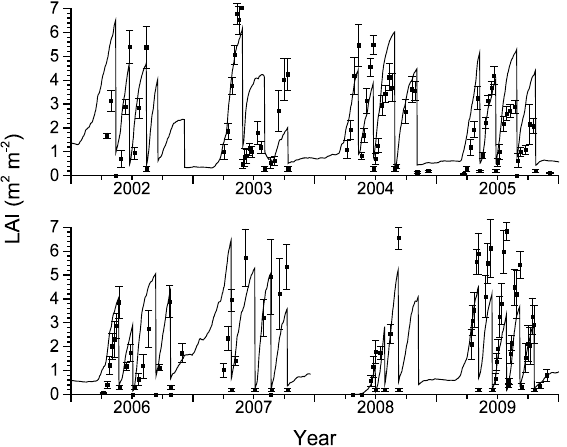
Figure 2. LAI measured (symbols) and modelled (lines) from 2002 through 2009 at the Oensingen intensively managed